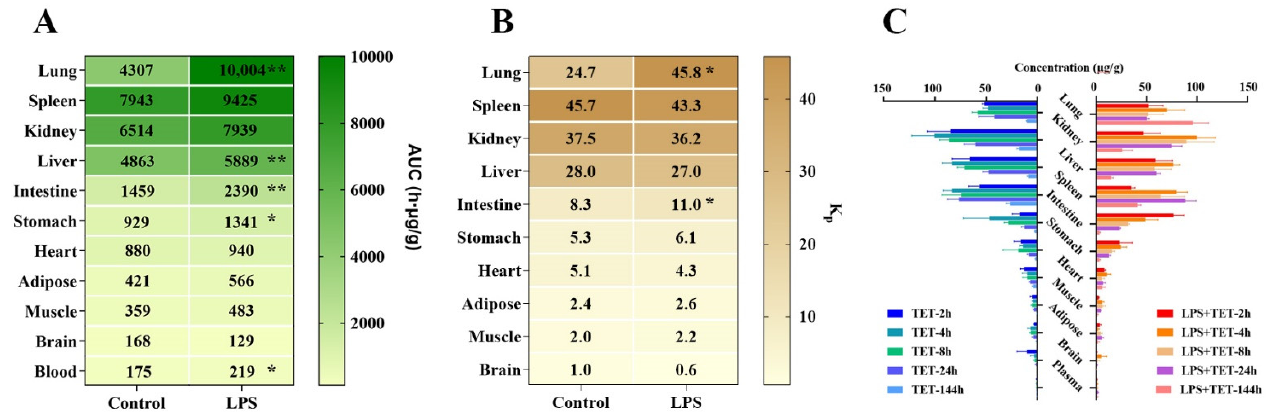
Figure 3. Biodistribution characters of TET in major tissues in normal and LPS-induced mice. Mean AUCs ( A ) and K p ( B ) of TET in different tissues after a single i.t. administration of 15 mg/kg TET in normal and LPS-induced mice ( n = 3, * p < 0.05, ** p < 0.01 compared to the normal mice group). ( C ) Comparative biodistributions of TET in major tissues in normal and LPS-induced mice at different time points. Table 2. Pharmacokinetic parameters of TET in major tissues and blood after a single i.t. administration in normal and LPS-treated mice ( n = 3, Mean ± SD).